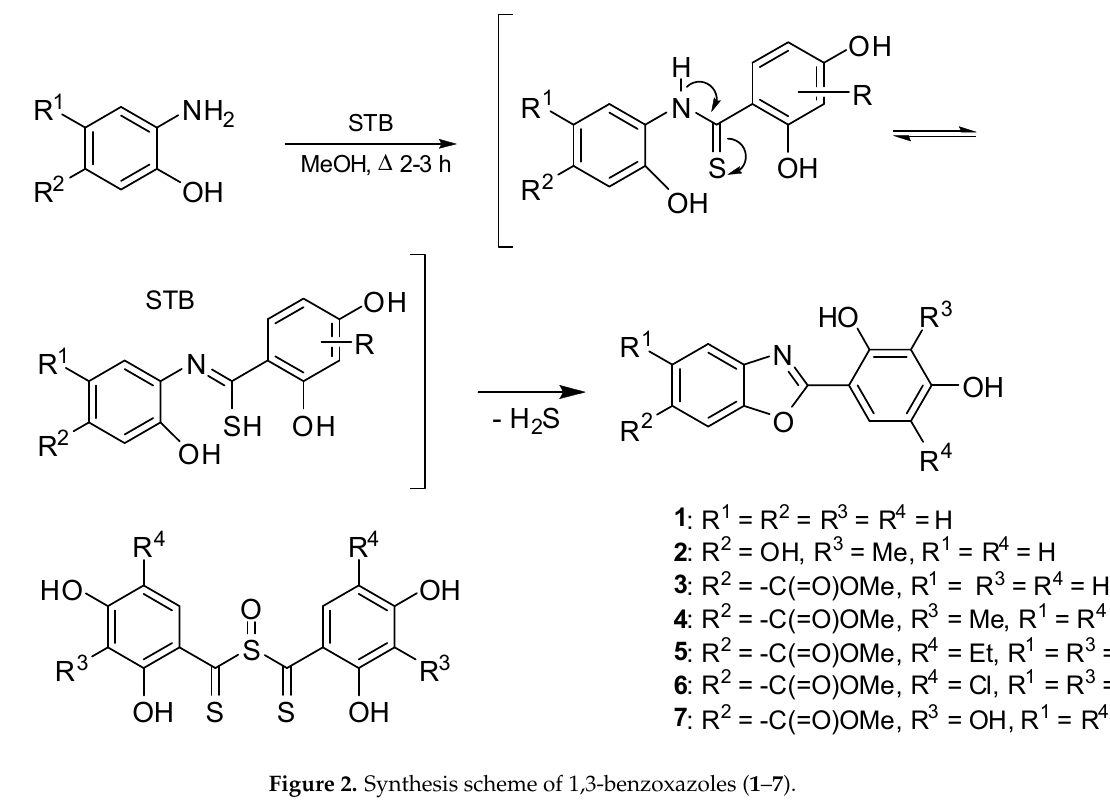
Figure 2. Synthesis scheme of 1,3-benzoxazoles ( 1 – 7 ).